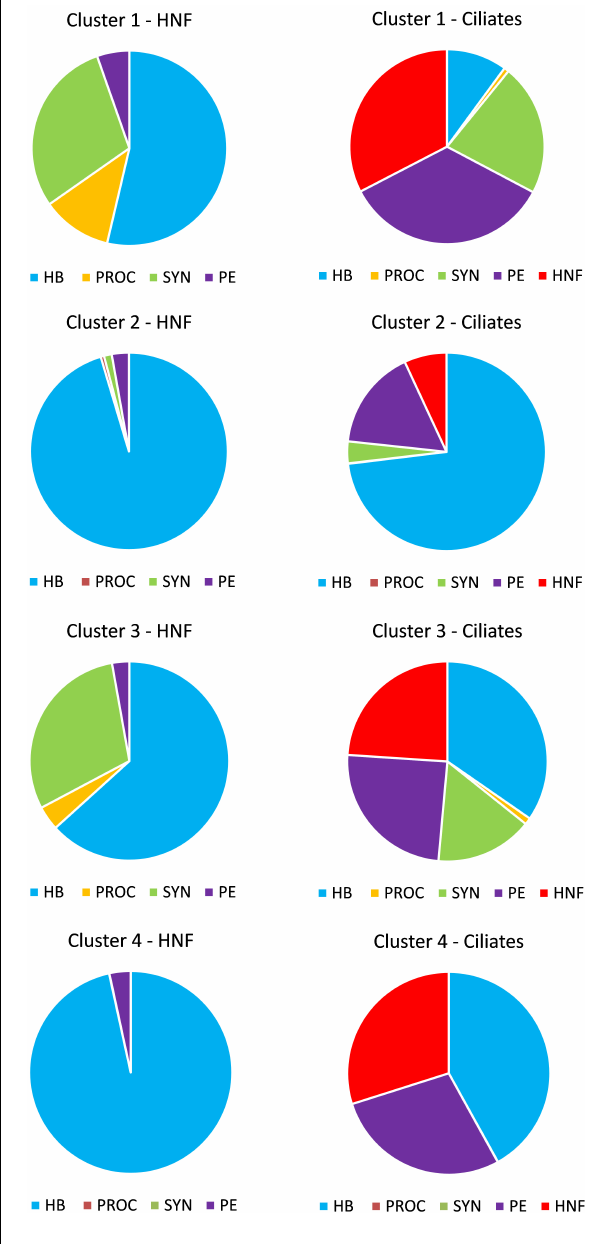
FIGURE 6 | Relative proportion of prey biomass to total biomass ingested by HNF and ciliates in four clusters. HB, heterotrophic bacteria; PROC, Prochlorococcus; SYN, Synechococcus; PE, picoeukaryotes; HNF, heterotrophic